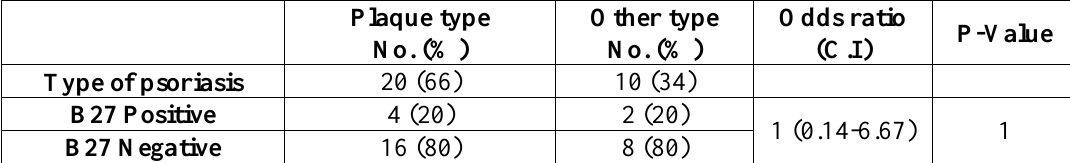
Table (3): Psoriasis type and HLA B27 allele frequency